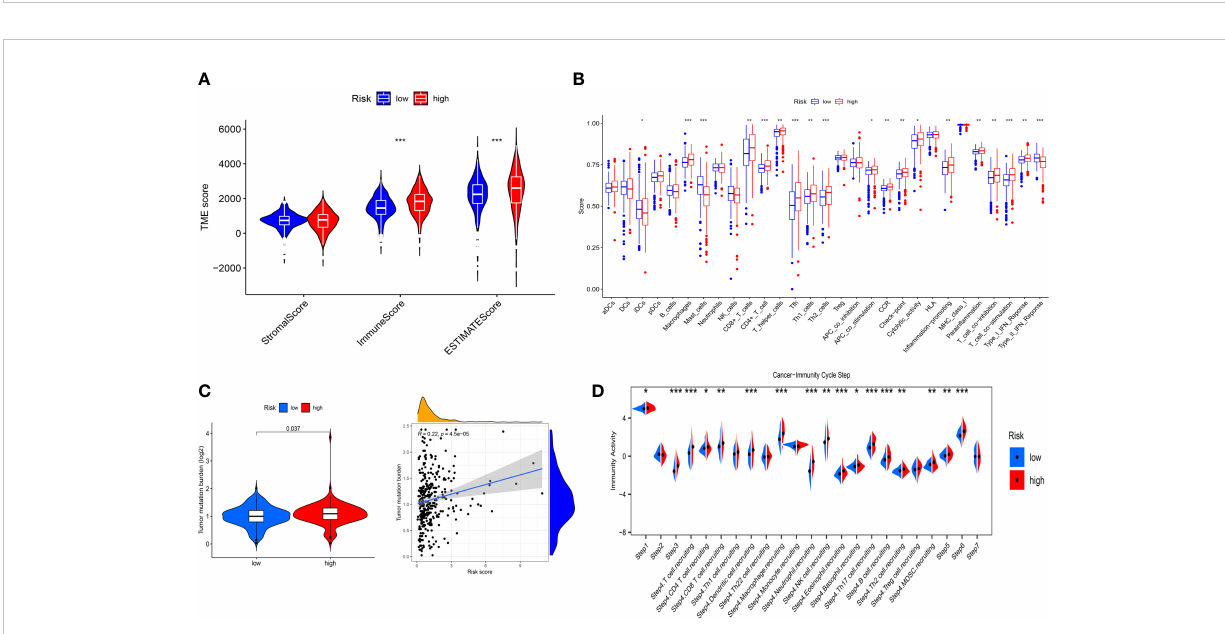
FIGURE 8 Immune landscape between the low- and high-risk groups. (A) Differences in the stromal score, immune score and ESTIMATE score. (B) Differences in the 16 immune cells and 13 immune-related pathways between the low- and high-risk groups. (C) Correlation between TMB and risk score. (D) Differences in the immune activity score of cancer-immunity cycle steps between the low- and high-risk groups. * p<0.05, ** p<0.01, ***